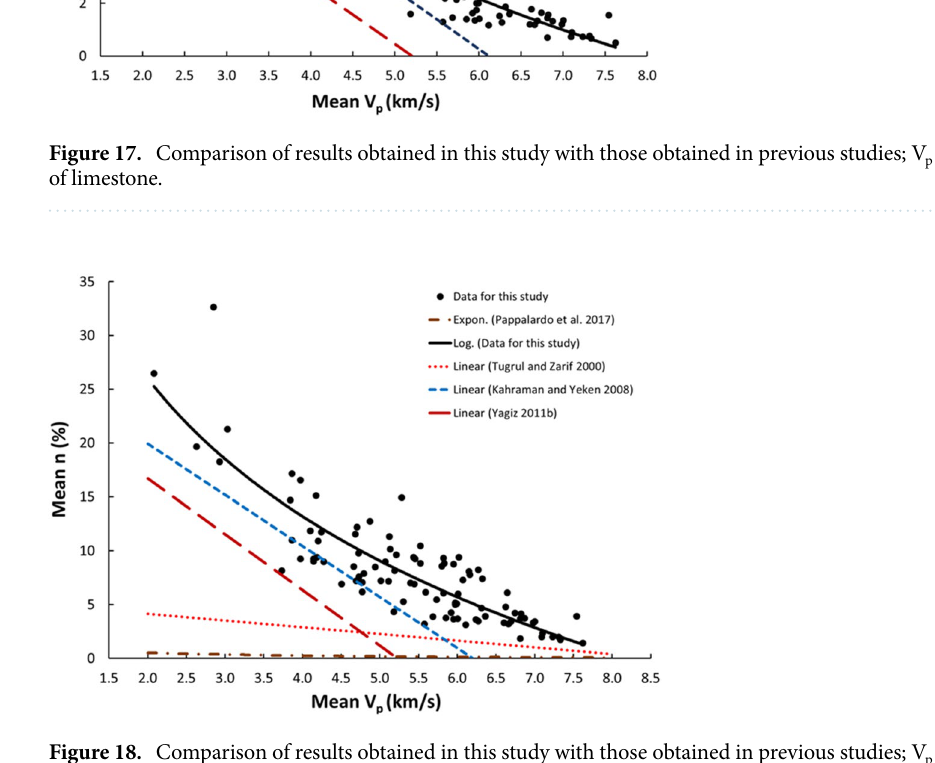
Figure 18. Comparison of results obtained in this study with those obtained in previous studies; V p versus n of